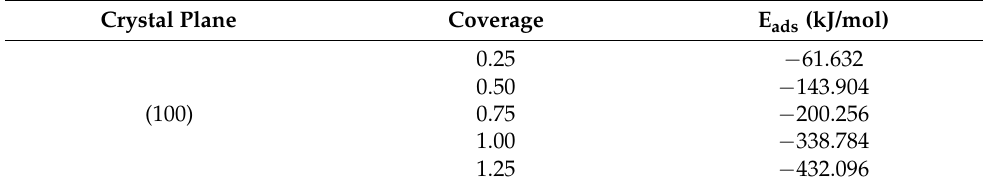
Table 4. Adsorption energy of multimolecular water on MgO (100) plane.